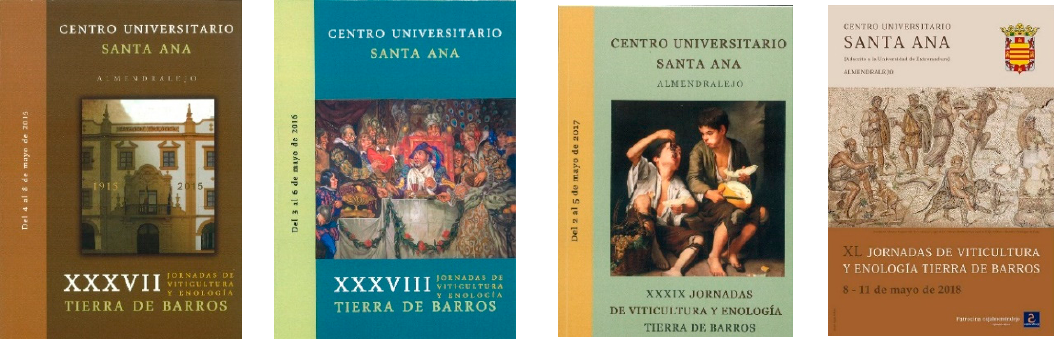
Figure 2. Posters of the last four years of the Conference of Viticulture and Oenology celebrated in Almendralejo (Badajoz,